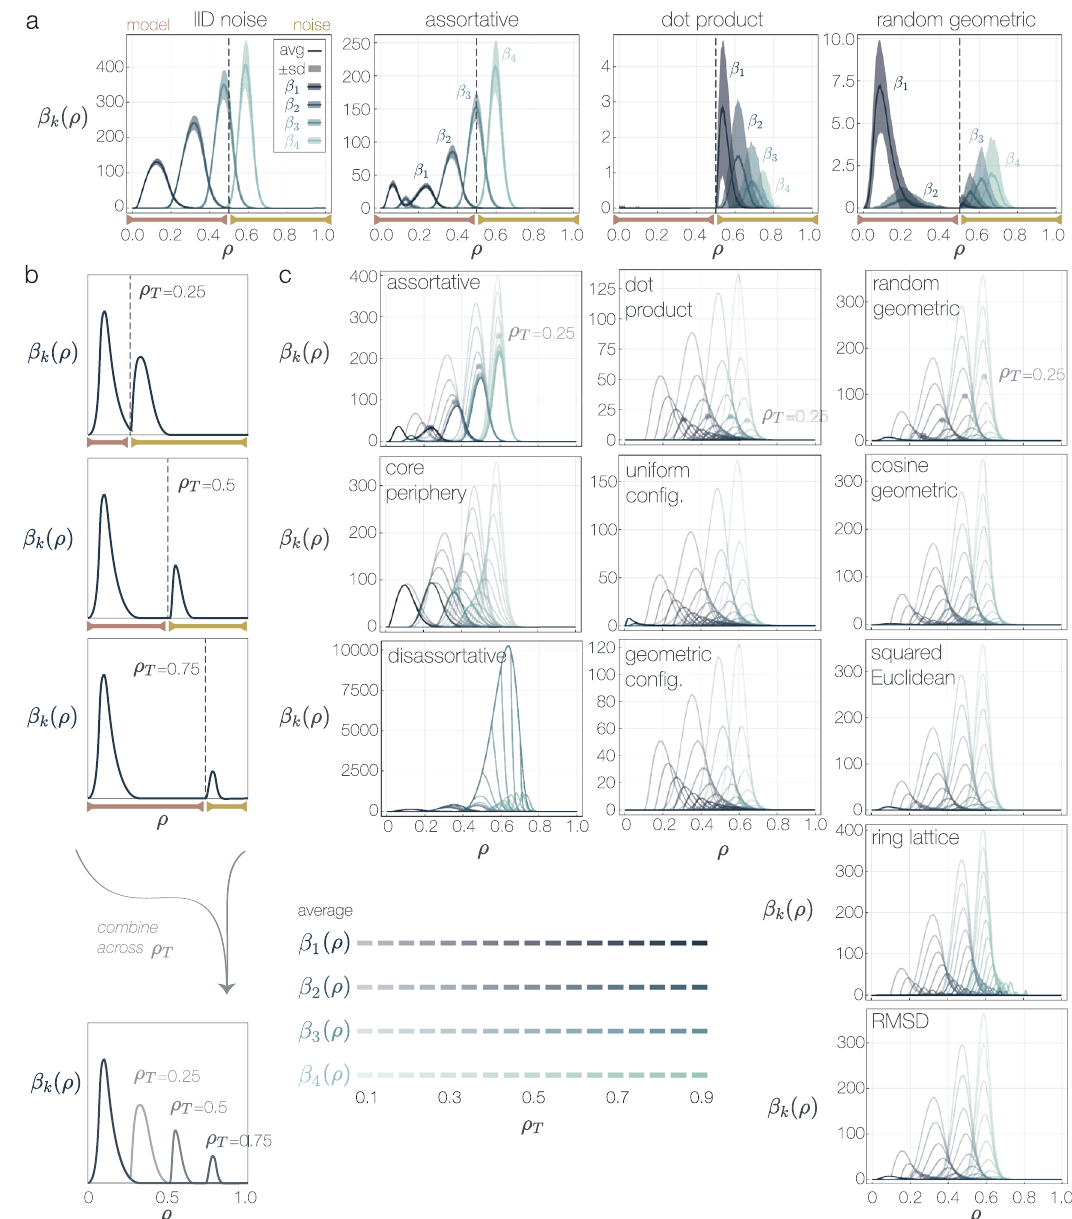
Fig. 3 Betti curves of added noise vary based on the underlying network model. a Examples of network models that support varying structure of added noise (IID independent and identically distributed). Solid lines indicate mean Betti curve and shaded region corresponds to ±1 standard deviation. See Supplementary Fig. 4 for all models. Threshold edge density value ρ T indicated by dashed lines. b Repeating the thresholding process across values of ρ T , we create a summarized visualization of the Betti curves. c Mean Betti curves for each of 11 tested network models (IID noise not included). Curve opacity indicates ρ T , and color indicates dimension as shown in the legend. For the fi rst model in each column Betti curve peaks at ρ T = 0.25 are marked with a dot to emphasize the scaling and shifting of Betti